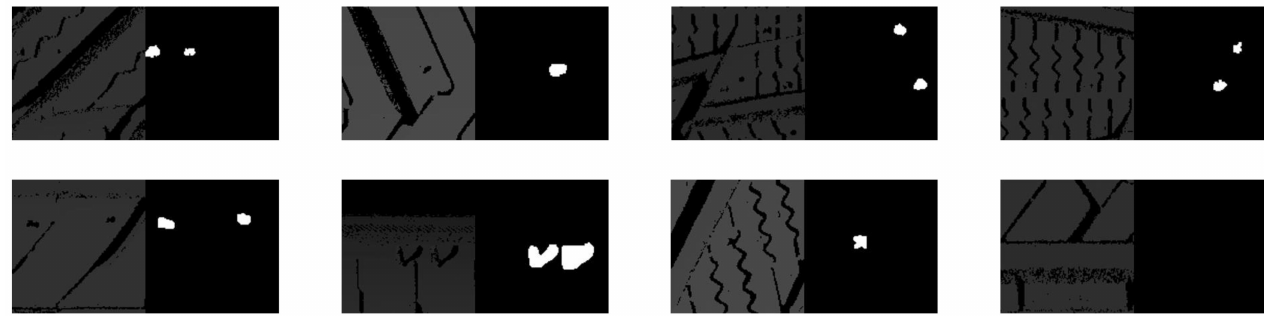
Figure 11. Sample image data were used to train the model. In each image, the image on the left is the tire depth image (.tif), and the image on the right is the image marked vent spew